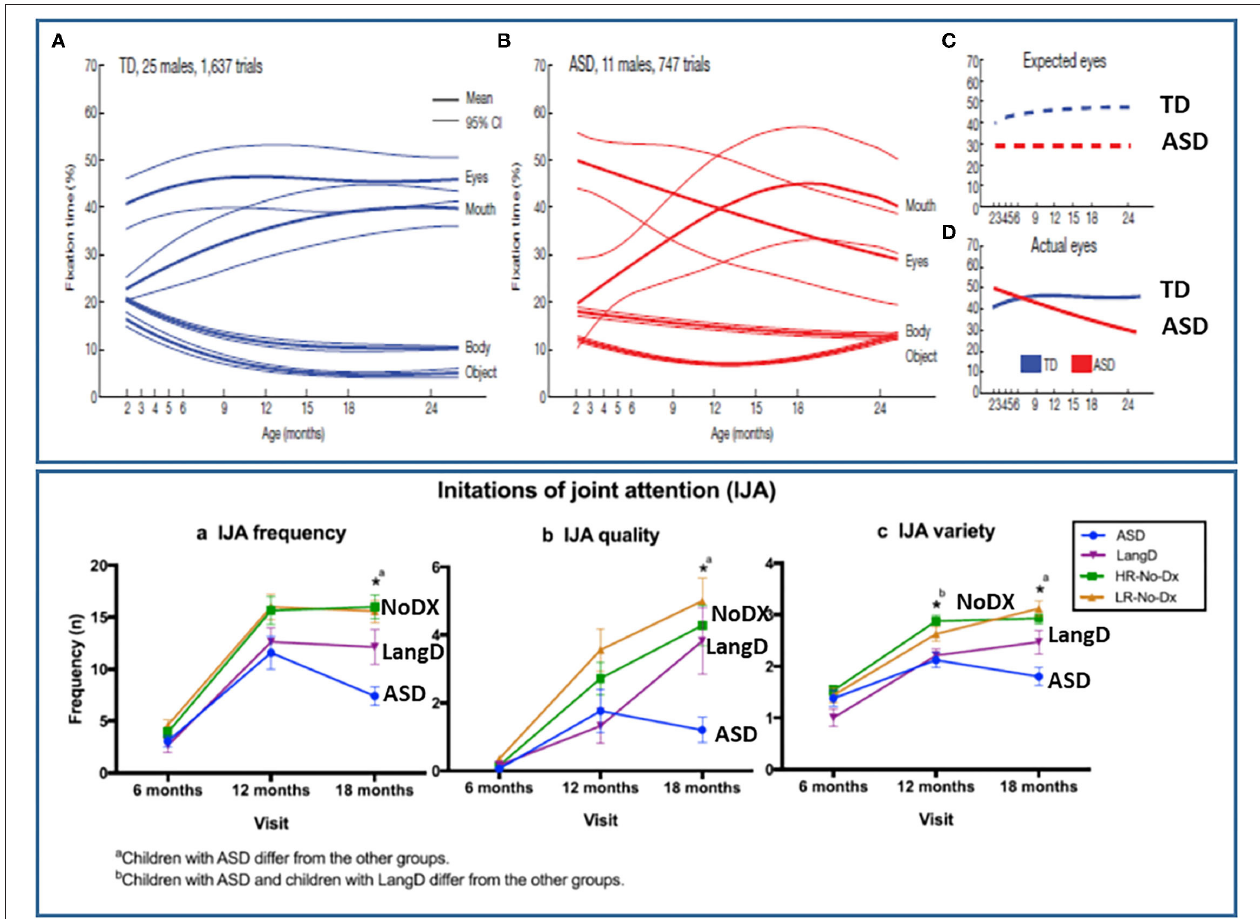
FIGURE 3 | Illustration of the onset of social attention symptoms in the 6 th to 12 th month of development for social orienting (top panel) and joint attention (bottom panel) from Jones and Klin ( 34) and Franchini et al. (23), respectively. Figures reprinted with permissions from, (Top panel) Nature, Springer Nature, and (Bottom panel) Journal of Abnormal Child Psychology, Springer